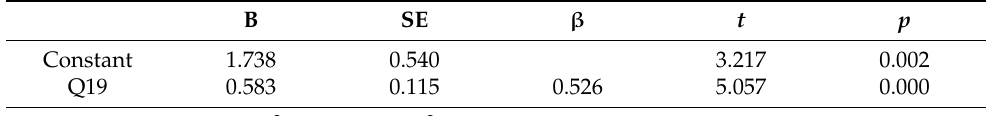
Table 6. A regression model of patients’ general satisfaction toward quarantine life in the CTC (Q9) ( N = 69). B SE β t p Constant 1.738 0.540 3.217 0.002 Q19 0.583 0.115